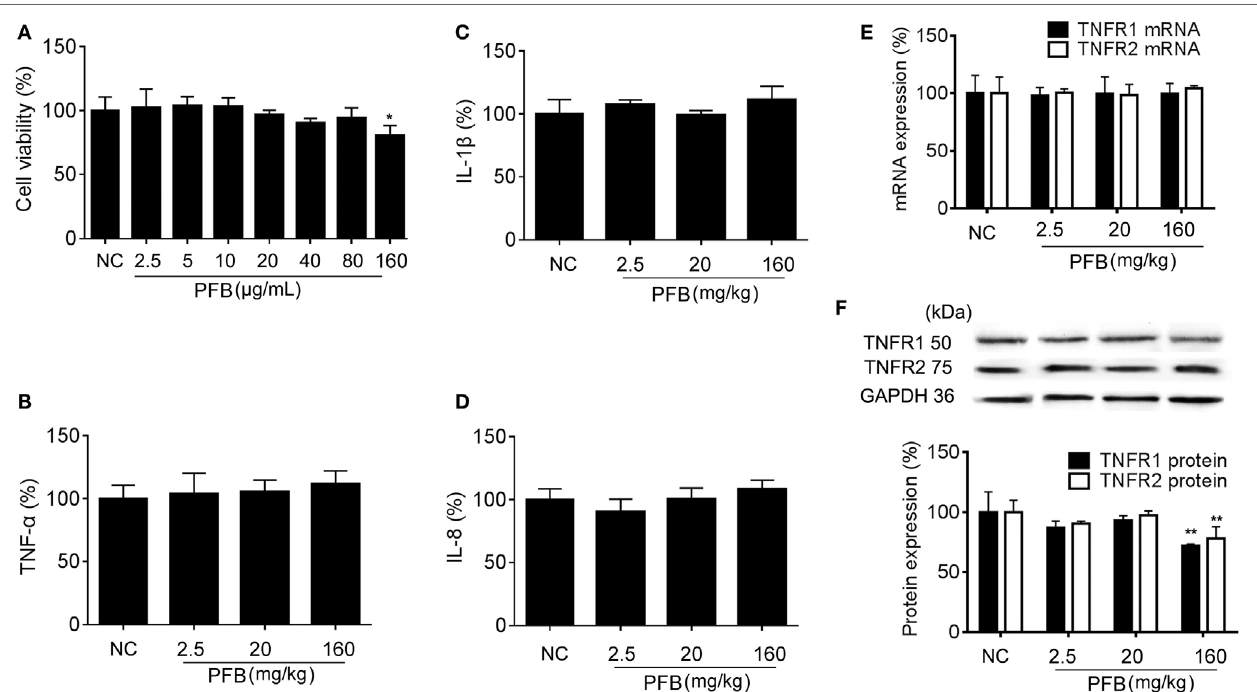
FigUre 1 | Toxicity of purified fruit bromelain (PFB) in normal cells and rats. (a) Cytotoxicity of PFB was studied by MTT assay in the intestinal epithelial cell line IEC-6. PFB was administered to rats by gavage once daily for 14 consecutive days ( n = 6). Expression levels of the colonic cytokines TNF- α (B) , IL-1 β (c) , and IL-8 (D) were examined by enzyme-linked immunosorbent assay, and expression levels of mRNA and protein of TNFR1 and TNFR2 (e,F) were examined by quantitative real-time PCR and western blotting, respectively ( n = 6). Data are expressed as the mean ± SD. Values in the normal control (NC) group are set to 100%, and other values are given relative to the NC